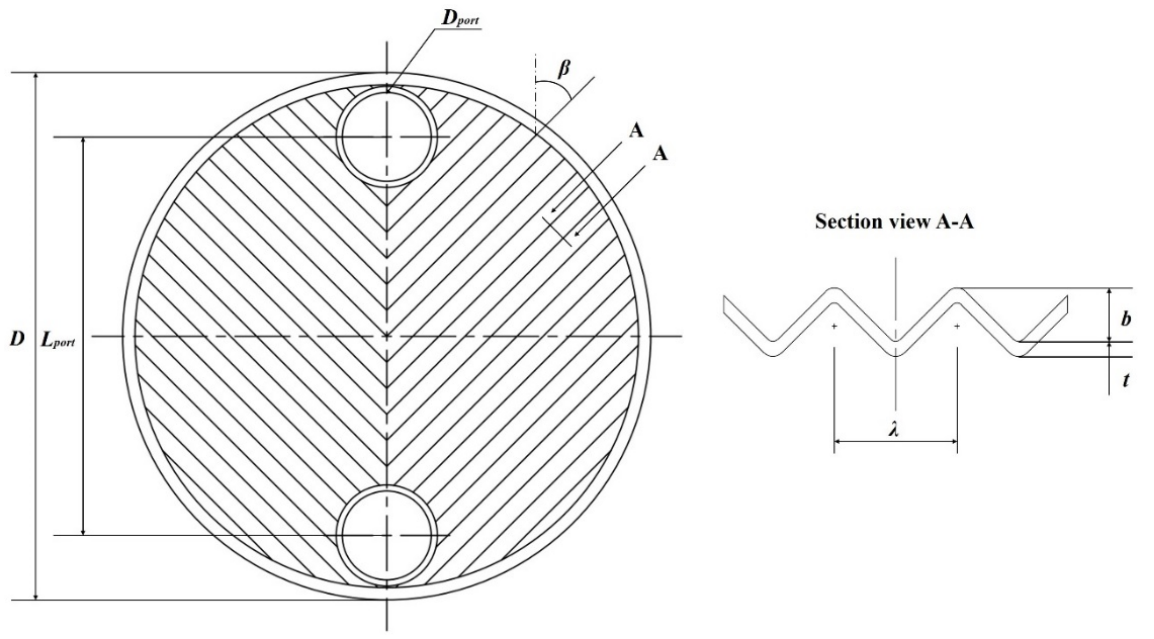
Figure 3. Schematic of the circular plate. Table 1. Geometries of the tested PSHE.